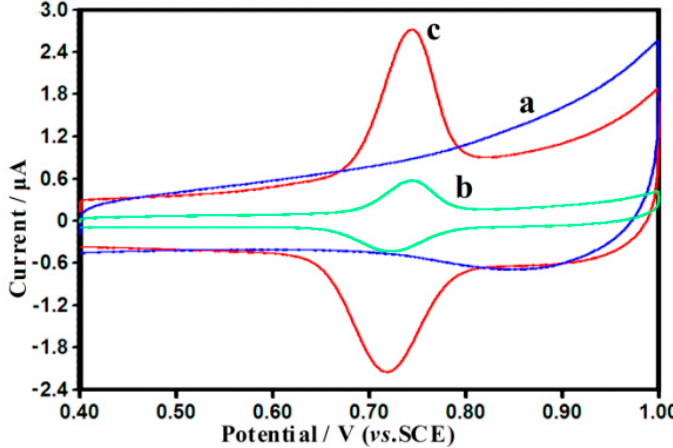
Figure 4. Cyclic voltammograms of (a) the ZnONF/CPE in pH 5.0 phosphate buffer solution (PBS) without SY; (b) the 40 µg/L SY in pH 5.0 PBS at the bare CPE, and (c) the ZnONF/CPE. Reprinted with the permission of Reference [24].